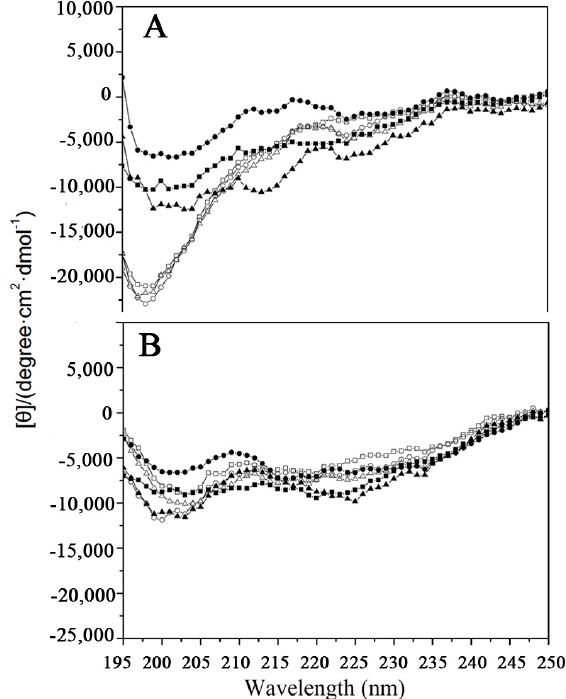
Figure 1. Circular dichroism spectra of the peptides. Panels A and B show the CD spectra of peptides in KP buffer and in the presence of 50% ( v / v ) TFE, respectively. Symbols used are as follows: solid square ■ for tigerinin-1R; solid circle ● for tigerinin-1R-L4; solid triangle ▲ for tigerinin-cyclic; open square □ for tigerinin-linear; open circle ○ for [C3K]tigerinin-1R; and open triangle △ for [C11K]tigerinin-1R.